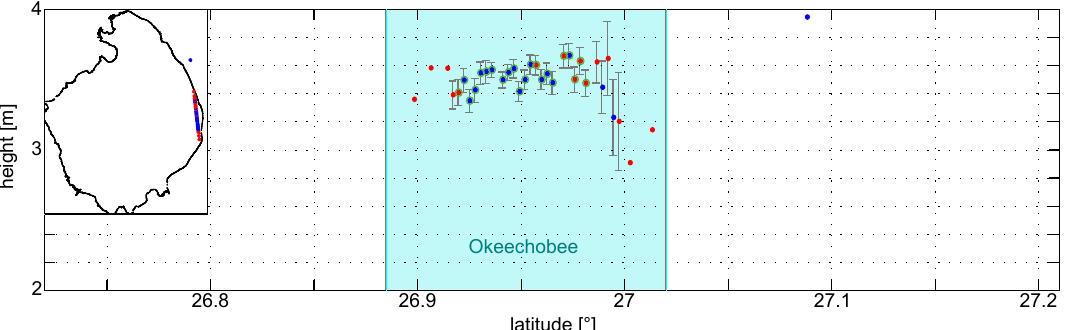
Figure 6. Water heights determined with the modified Improved Threshold Retracker (ITR) for a track crossing the Lake Okeechobee. Water heights of the class water are marked in blue, water heights of the class land-water transition are marked in red and the moving standard deviations of the water heights are displayed by the gray errorbars. Valid results after the outlier rejection are marked in green. The lake surface is indicated by the light blue area.